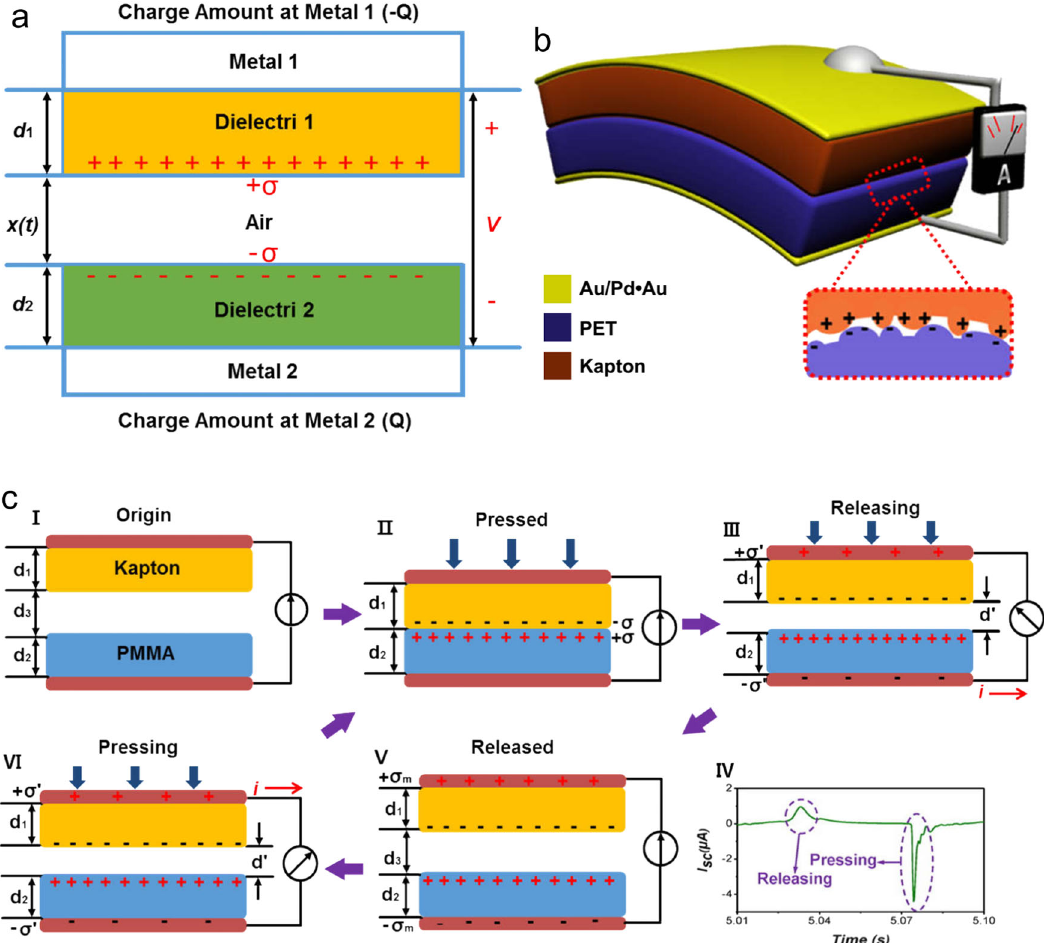
Fig. 1 a Theoretical model for dielectric-to-dielectric mode. Reproduced with permission. 19 Copyright 2013 American Chemical Society. b Construction of the fi rst fl exible TENGE. Reproduced with permission. 7 Copyright 2012 Elsevier. c Proposed mechanism of the